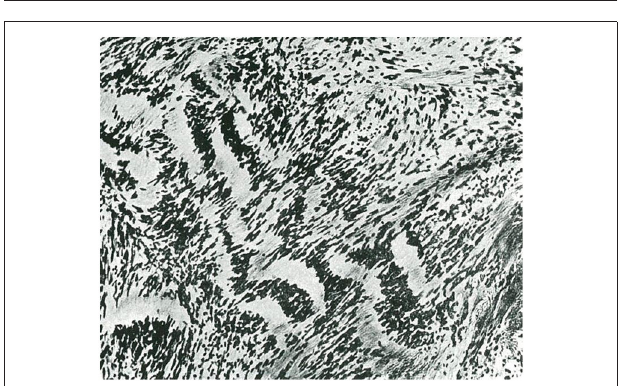
FIGURE 7 | Neurinoma. Grouping of the nuclei in rows or palisades (taken from Río-Hortega, 1933a).